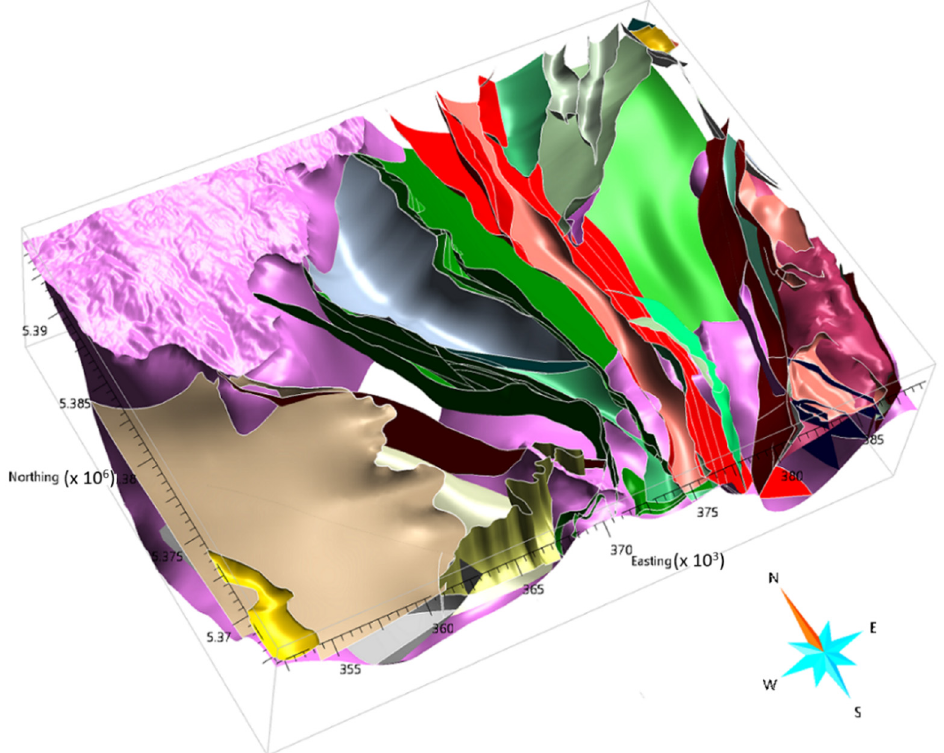
Figure 15. A 3D schematic illustrating the Rosebery–Pieman reference model. Lithological surfaces are represented by multicolored surfaces. Pink surfaces equal Devonian Granite and magenta surfaces equal Cambrian Granite. Red surfaces represent the fault network architecture.